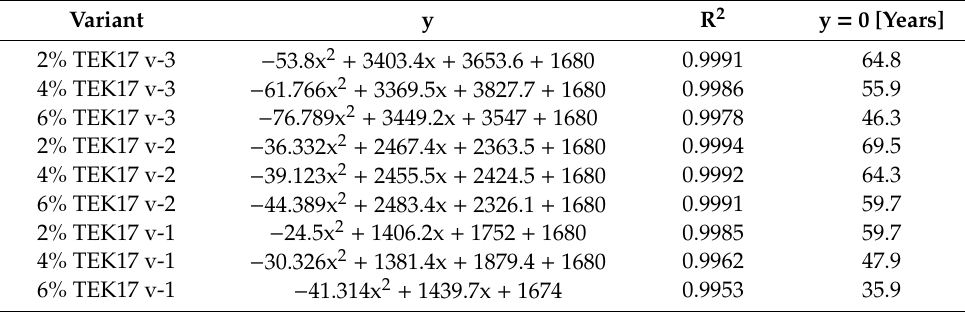
Table 8. Polynomial regression equations of the curves in Figure